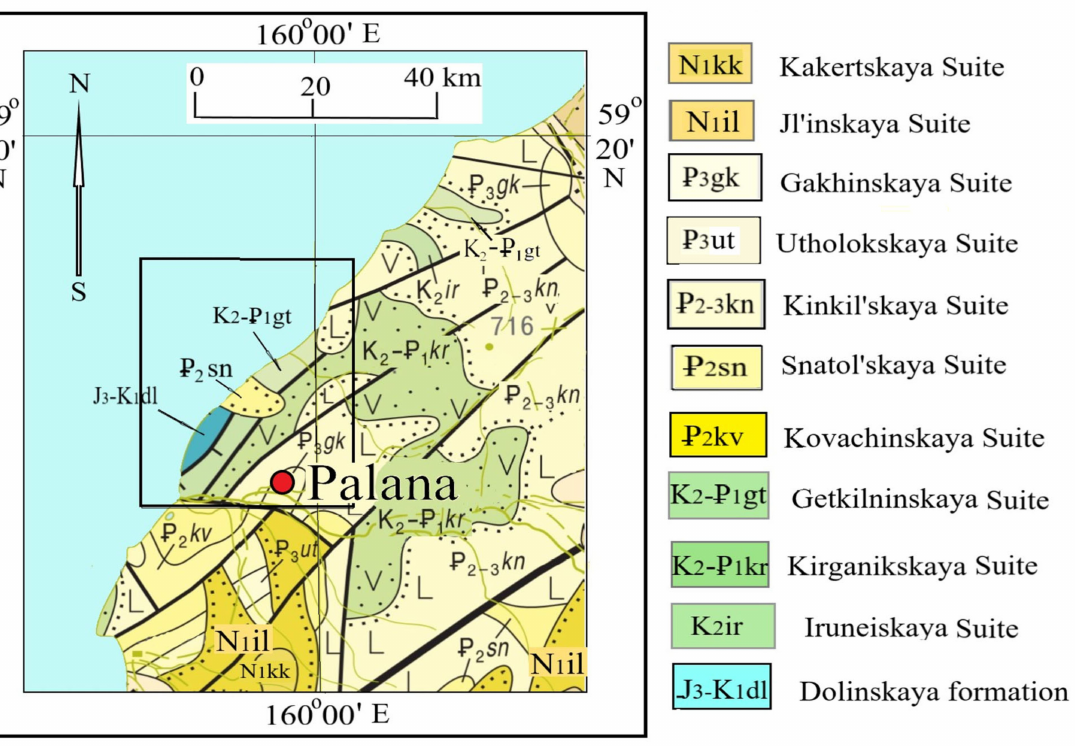
Figure 6. Palansky Section studied area, Western Kamchatka